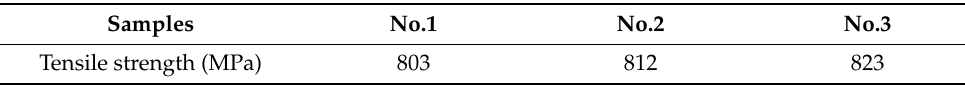
Figure 8. Polarization curves of DSS 2205 solid wire MIG welding joints under three different shielding gases. Table 3. The tensile strength values of No.1, No.2 and No.3 samples.